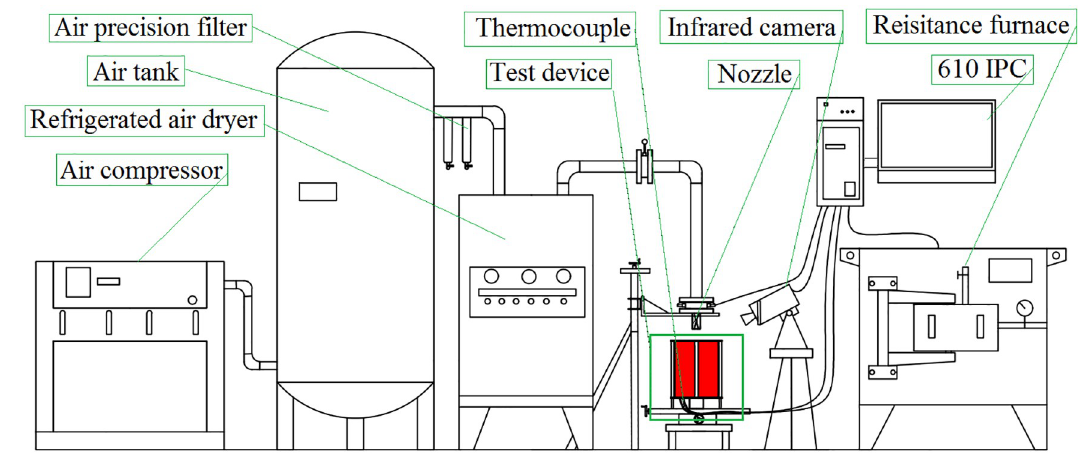
Fig 5. Schematic illustration of the experimental setup.